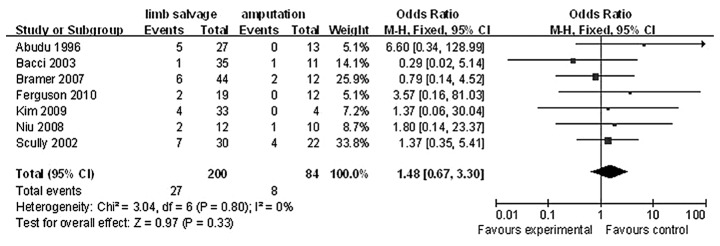
Forest plot of comparison: local recurrence of limb salvage vs. amputation for the treatment of osteosarcoma in patients with pathological fracture.